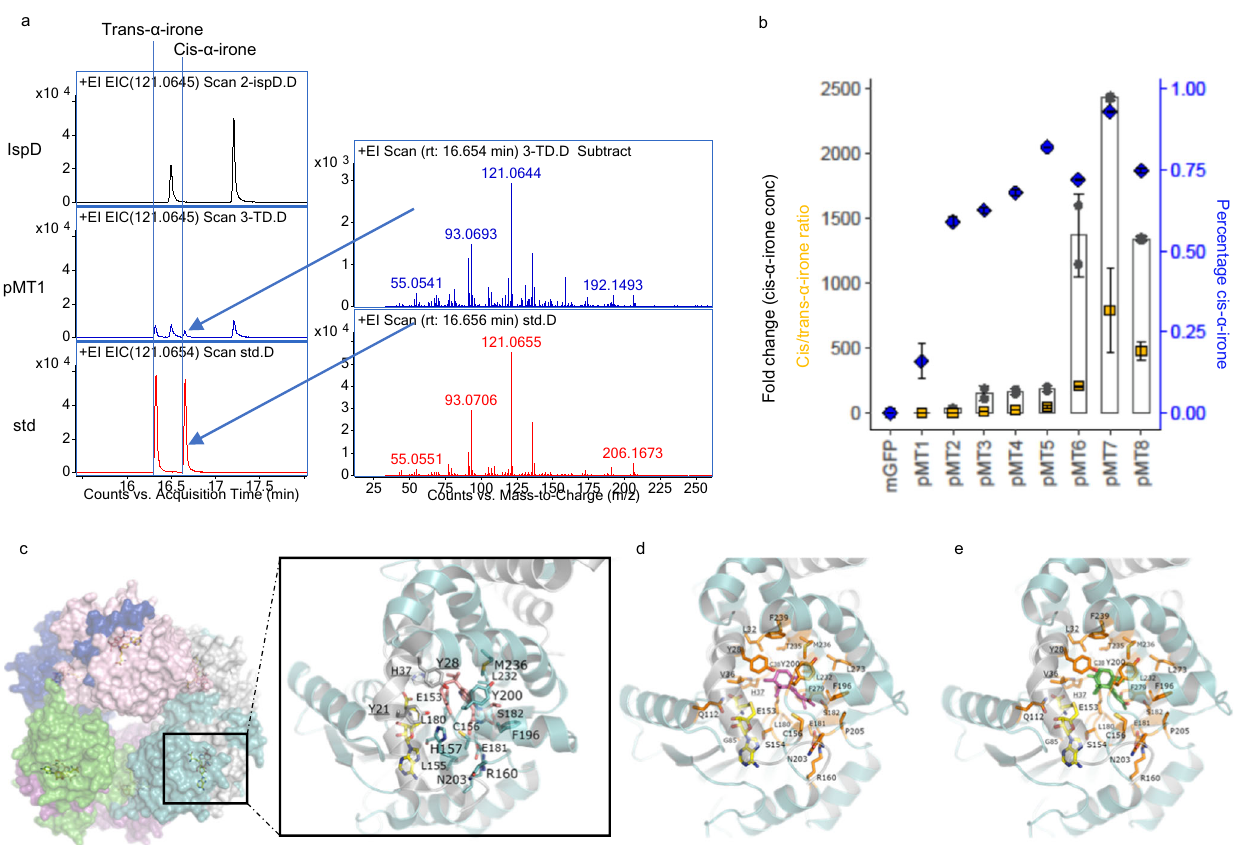
Fig. 2 | Promiscuous methyltransferase catalyses psi-ionone to α -irone. a Cell lysates overexpressing IspD (negative control) or pMT1 were used to assay against psi-ionone.Thereactionmixtureswereincubatedat28°Cfor2daysandsubjected to headspace solid-phase microextraction coupled to gas chromatography-mass spectrometry (HS-SPME-GCMS) analysis. Methylated products that correspond to trans- α -irone and cis- α -irone were detected in the reaction containing pMT1. The retention time and mass spectrum of the irones detected are the same as the synthetic chemical standard (std) from Sigma Aldrich. b Cis- α -irone, trans- α -irone and β -irone were quanti fi ed for each pMT mutant by HS-SPME-GCMS against an externalstandardcurve. The barchart representsthe averagefold changein cis- α - irone concentration compared to pMT1. The ratio between cis- α -irone to trans- α - irone concentration was calculated and represented as orange squares. The